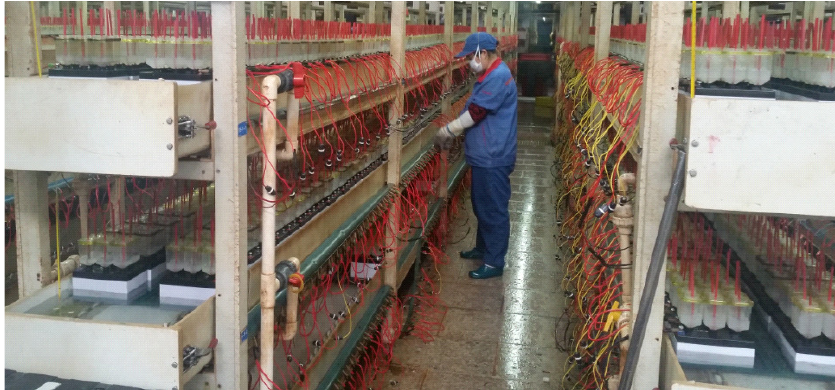
Figure 2. Discharge curve automatic measurement.